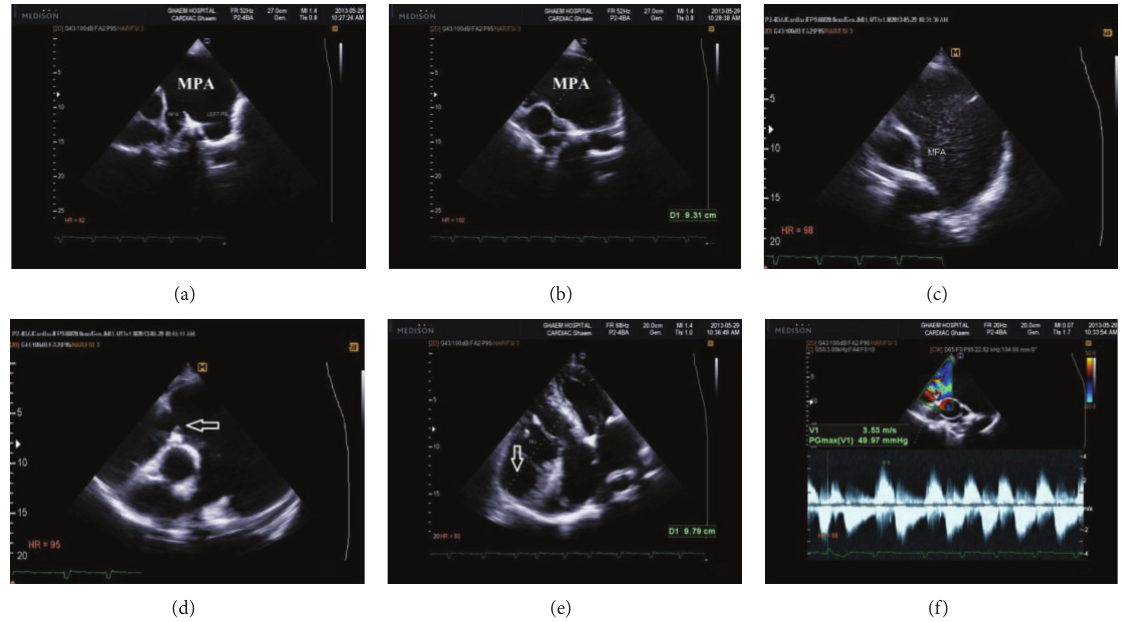
Figure 2: Patient’s echocardiography: (a), (b), (c), and (d) parasternal short axis view, visible pulmonary valve (PV), annulus, and retracted leaflets with severe dilatation of main pulmonary artery and both branches (the arrow shows the dysplastic pulmonary leaflet); (e) apical 4 chamber view revealed severe aneurysmal dilatation of right ventricular inflow (the arrow); (f) doppler study of pulmonic valve from high left parasternal view. RPA: right pulmonary artery. PA: pulmonary artery. MPA: main pulmonary artery. RV: right